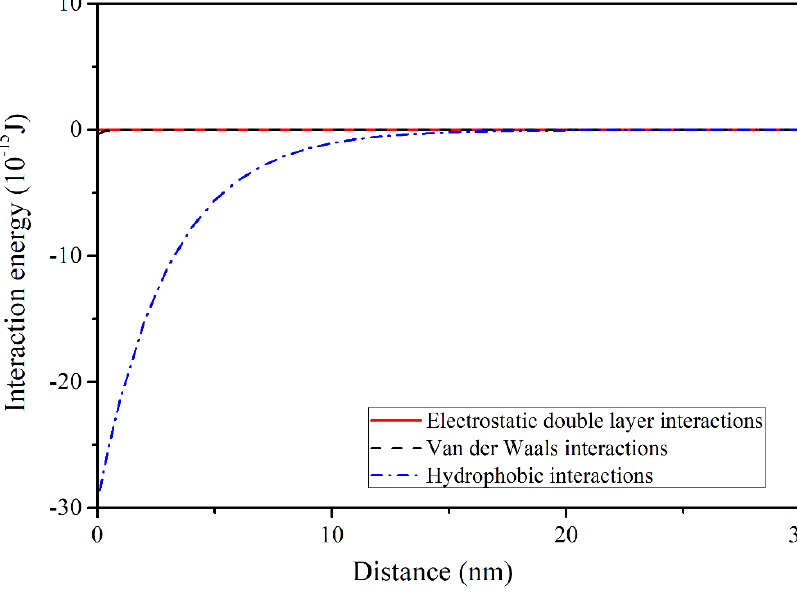
Figure 9. The interaction energies of hydrophobized magnetite–microcrystalline graphite at pH 7.